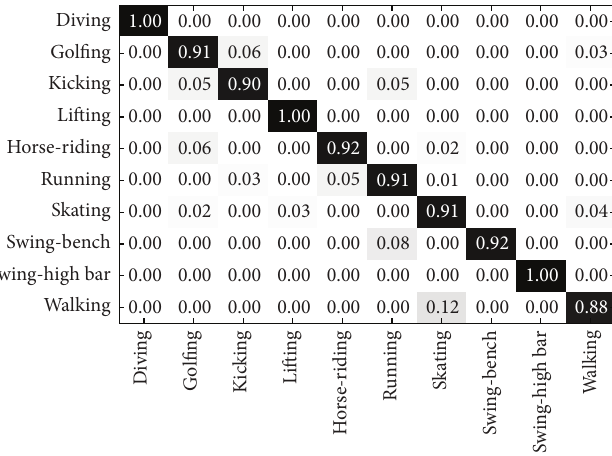
Figure 7: 4-level Spatial Pyramid Match